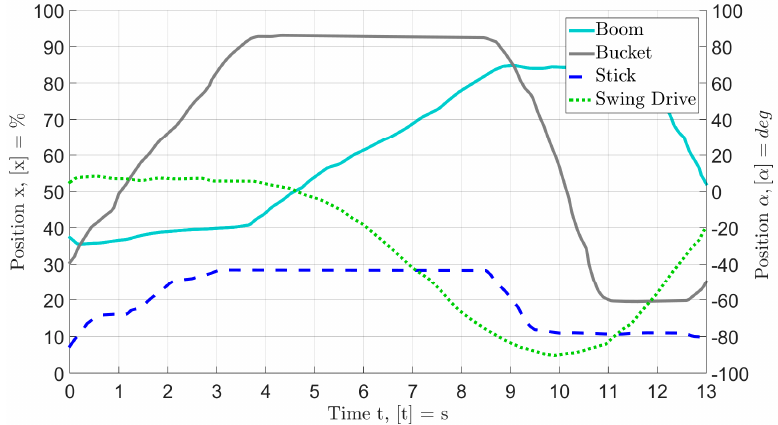
Figure 4. 90 Degree digging cycle of a hydraulic excavator, Data taken from [14].